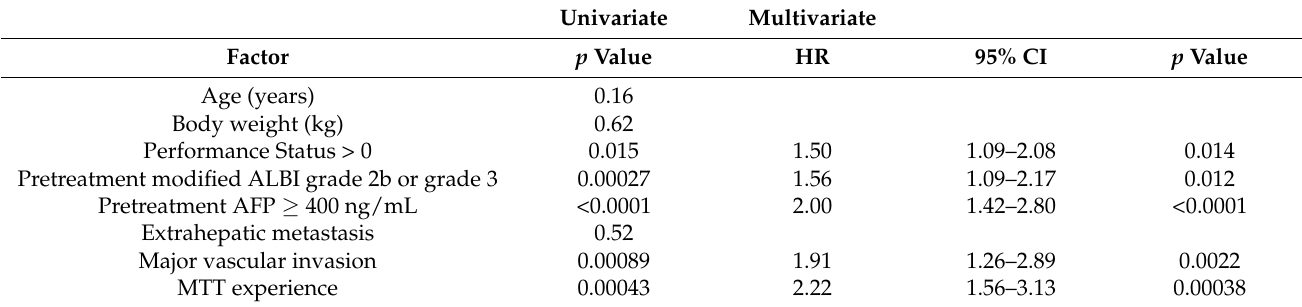
Table 5. Factors associated with mortality in lenvatinib therapy (All patients).